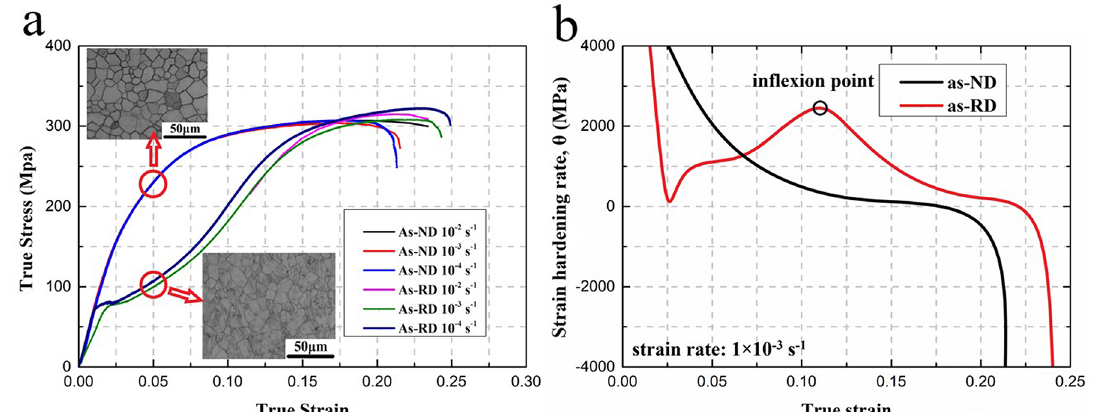
Figure 4. Specimens compressed at a strain rate range of 10 -4 s −1 ~10 -2 s -1 (a) True stress-strain curves; (b) Strain hardening curves.